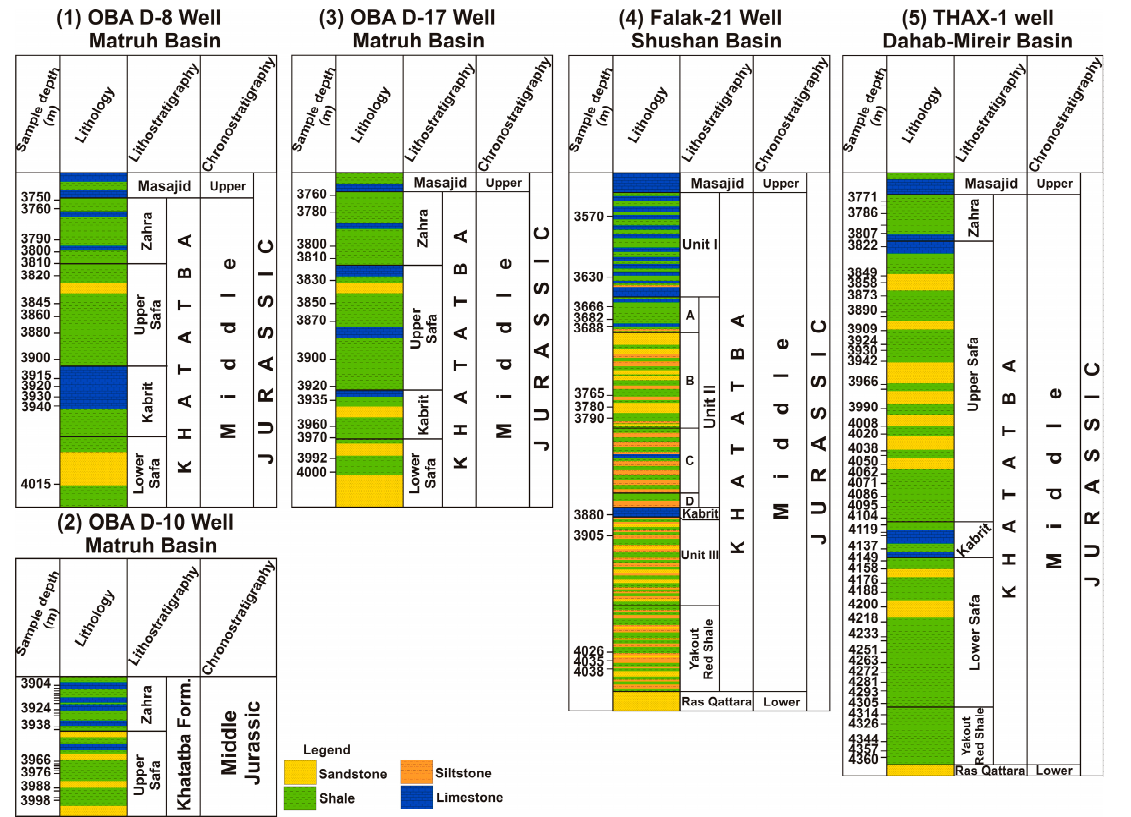
Figure 2. Lithostratigraphic successions of the Middle Jurassic Khatatba Formation in the OBA D-8, OBA D-10, and OBA D-17 wells in the Matruh Basin [6], the Falak-21 well in the Shushan Basin [5], and the THAX-1 well in the Dahab-Mireir Basin in the north Western Desert, Egypt [6]. Representative depths of each sample are also shown. This study focuses on the Middle Jurassic Khatatba Formation in the OBA D-8, OBA D-10, and OBA D-17 wells in the Matruh Basin, the Falak-21 well in the Shushan Basin, and the THAX-1 well in the Dahab-Mireir Basin (Figures 1 and 2). The Khatatba Formation